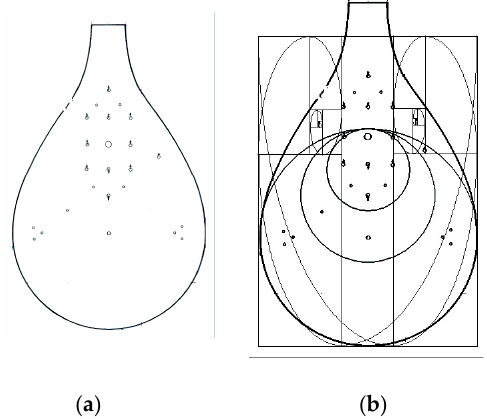
Figure 9. ( a ) Delroba pattern, ( b ) Application of the Golden Method to the Delroba.